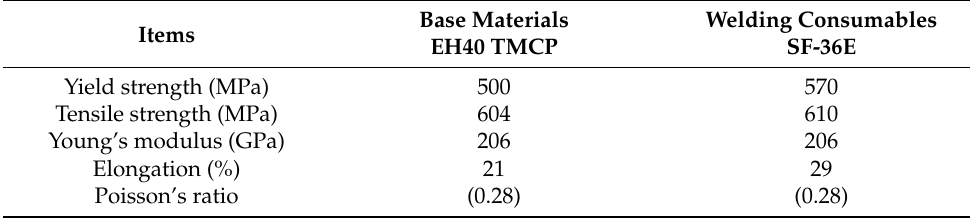
Table 1. Mechanical properties at 70 mm thickness.